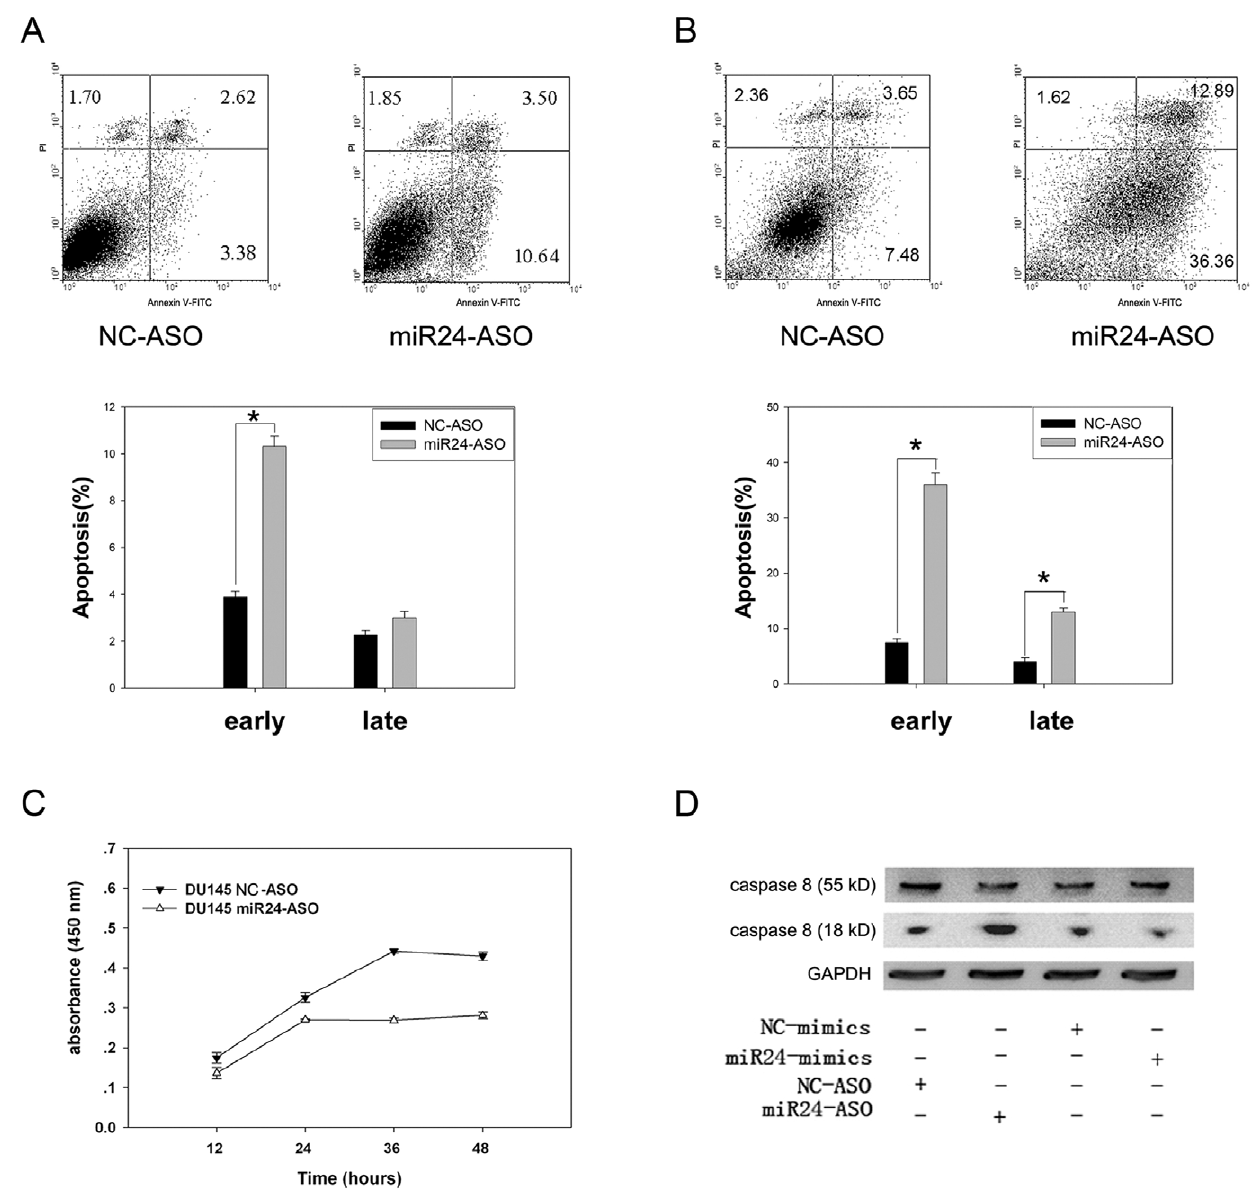
Figure 1. Down-regulation of miR-24 induces apoptosis and affects proliferation in DU-145 cells. (A) DU-145 cells were treated with 20 nM miR-24-ASO or NC-ASO for 48 h. Apoptosis was measured by FACS with Annexin V and propidium iodide staining (n=3 6 SE; * p , 0.01). Down- regulation of miR-24 induced apoptosis in DU-145 cells. (B) Apoptosis was induced for 2 h with 1 m M staurosporine, 48 h after transfection 20 nM miR-24-ASO or NC-ASO (n=3 6 SE; * p , 0.01). Apoptosis sensitivity increased significantly after transfection with miR-24-ASO. (C) Cell proliferation was measured by CCK-8 kit at the indicated time points after transfection with 20 nM miR-24-ASO or NC-ASO (n=3 6 SE). Down-regulation of miR-24 affected the proliferation of DU-145 cells. (D) Caspase-8 activation was detected by western blot analysis of pro-caspase 8 and the mature form of caspase-8 after 24 h of treatment (as above). Caspase-8 was activated after transfection with miR-24-ASO.